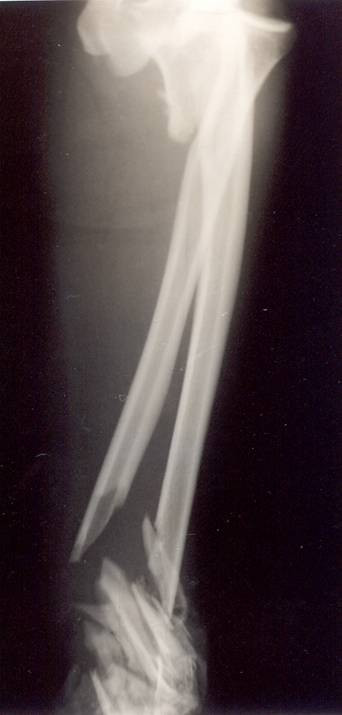
Radiographs of a 45-year-old man multiply injured who had an open complex injury of his left elbow and an ulnar nerve injury after a road traffic accident. Anteroposterior radiographs show a Monteggia fracture dislocation of the left upper arm with additional comminuted fractures of the distal end of both radius and ulna.